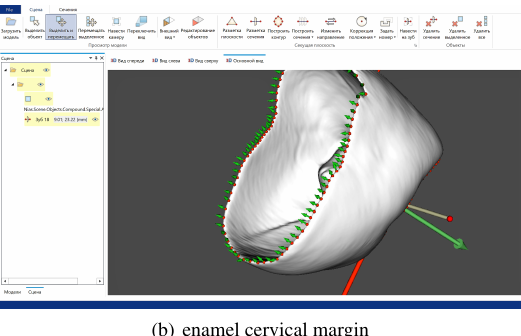
Figure 3. Final results of orientation according to occlusal Figure 2. Intermediate results of orientation according to surface contour (OSC) set on upper right first premolar of occlusal surface contour (OSC) set on upper right first premolar Suhghir-2 (a) and enamel cervical margin (ECM) on the same of Suhghir-2 (a) and enamel cervical margin (ECM) on the same tooth. tooth.